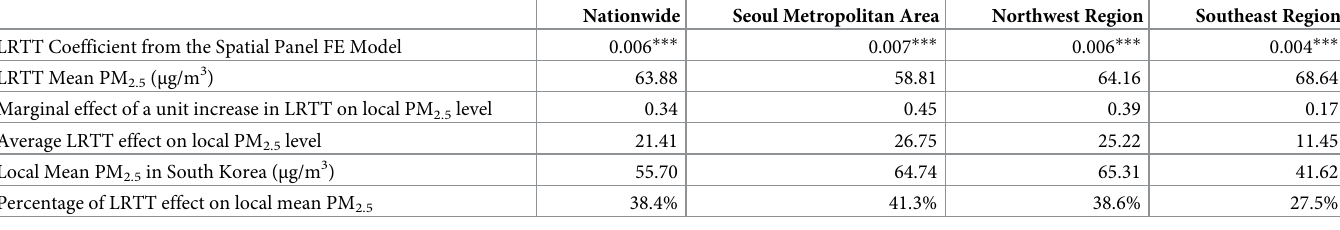
Table 4. Average effects of LRTT from China on local PM 2.5